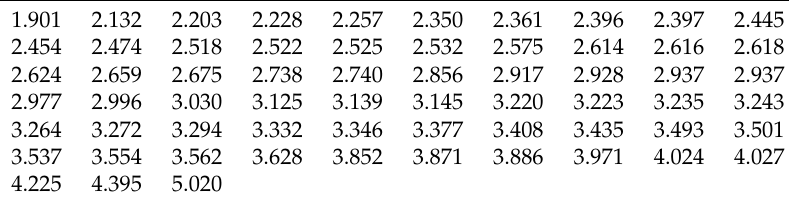
Table 4. Strength measured in GPA for carbon fibers tested under tension at gauge lengths of 10 mm.